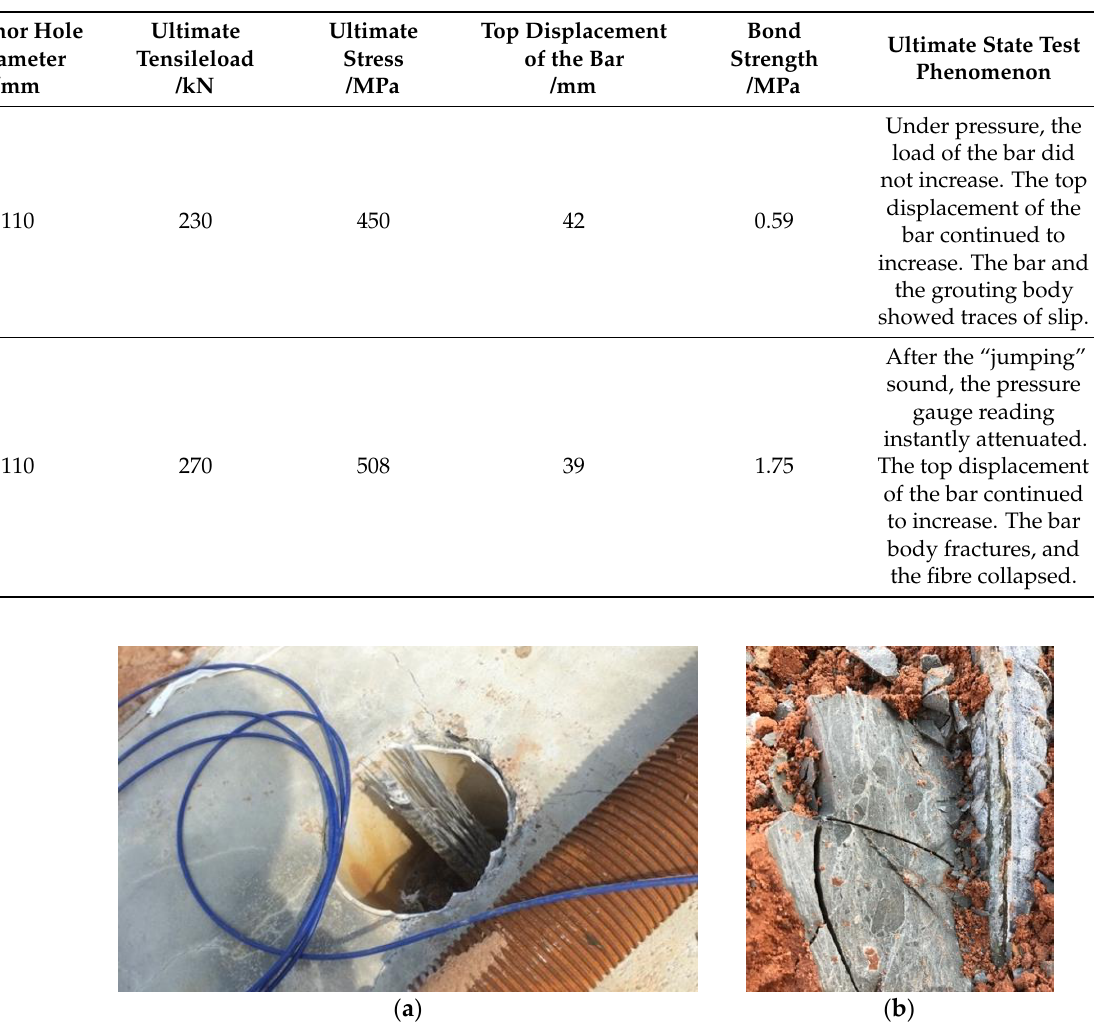
Table 8. Limit state characteristics of the bar body in the field pulling-out test.